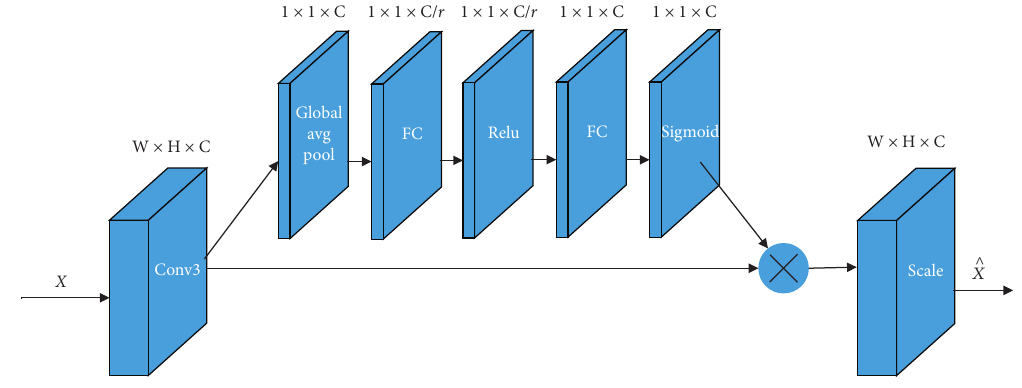
Figure 4: Squeeze-and-excitation (SE) block; c is a scaling